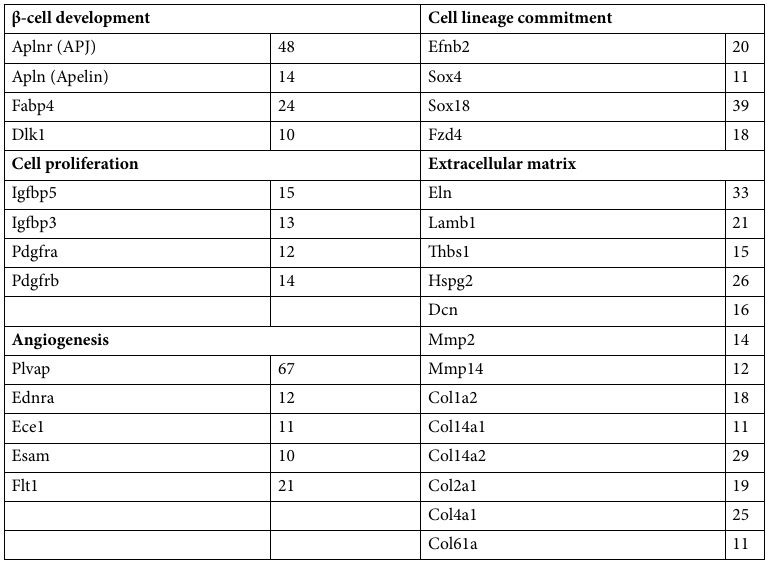
Table 1. Fold increase in selected genes over-expressed at least ten-fold in Ins + Glut2 LO cells relative to Ins + Glut2 HI cells isolated from pancreata of 7-day old mice. Expressed genes are grouped relative to biological roles reported previously. A full analysis of differential gene expression is shown in Supplementary Table 1. Efnb2 Ephrin-B2, Fzd4 frizzled-4, Igfbp IGF binding proteins 3, Pdgfr platelet-derived growth factor